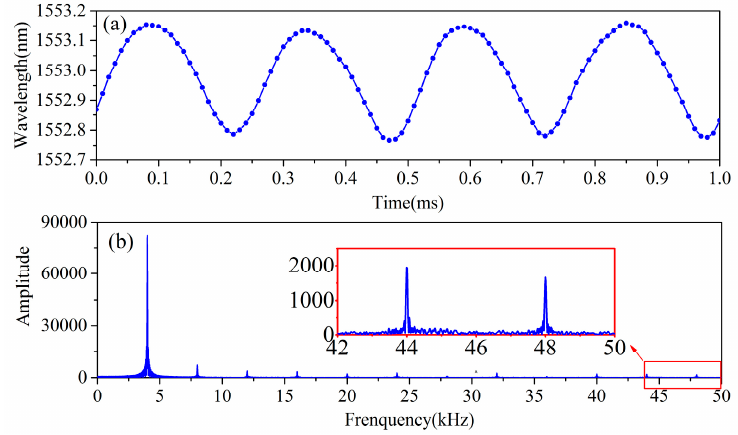
Figure 10. The results of the vibration experiment: ( a ) Distribution of demodulation in the time domain; ( b ) Complete frequency analysis of the demodulation result.